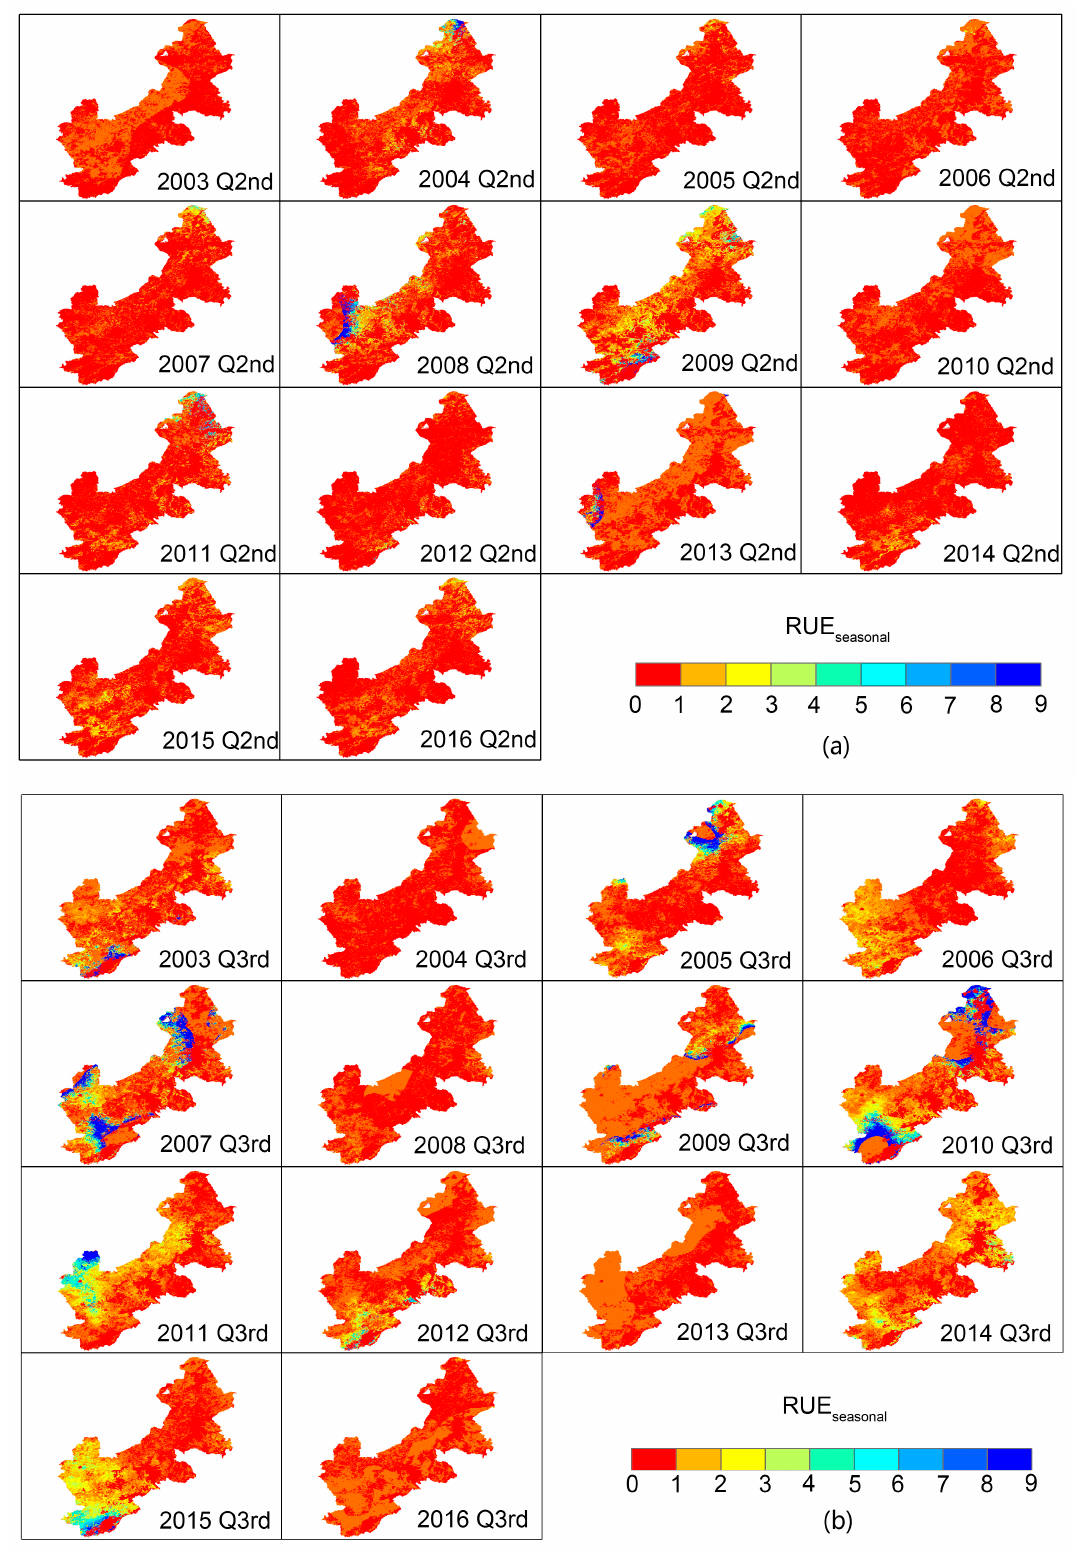
Figure 7. RUE seasonal time series calculation results of ( a ) Q2nd and ( b ) Q3rd. The greater the RUE seasonal value is, the greater the influence of human-induced factors is.